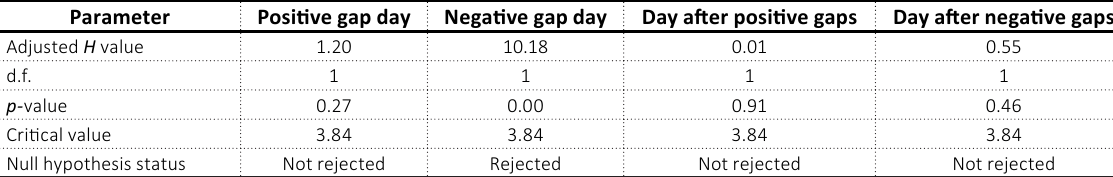
Table A4. Mann-Whitney test, the case of the UX index over the period 2009–2018